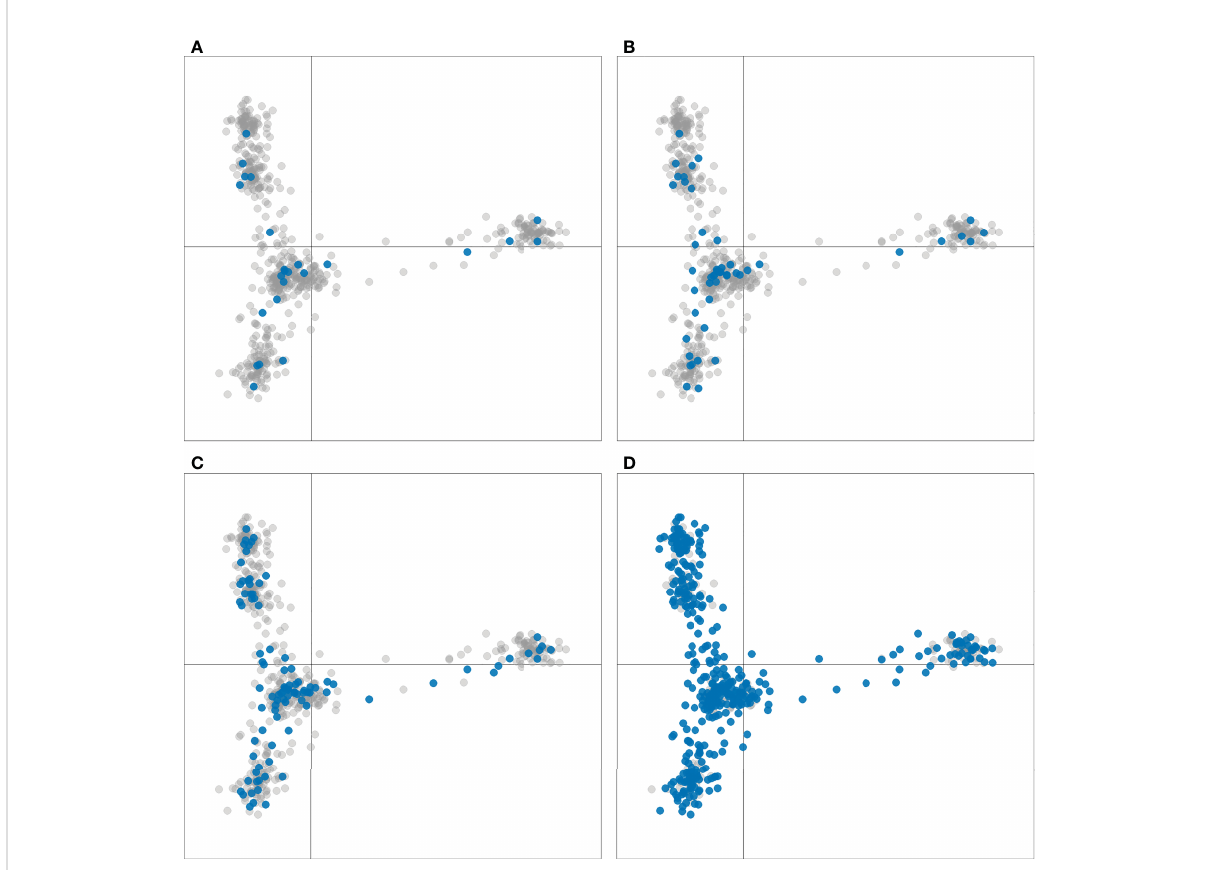
FIGURE 5 Discriminant analysis of principal components (DAPC) of 604 sweetpotato ( Ipomoea batatas ) accessions scatterplots for K=6. Accessions included in the breeder subsets of (A) 24, (B) 48, (C) 96, and (D) 384 are colored blue, all other accessions are colored